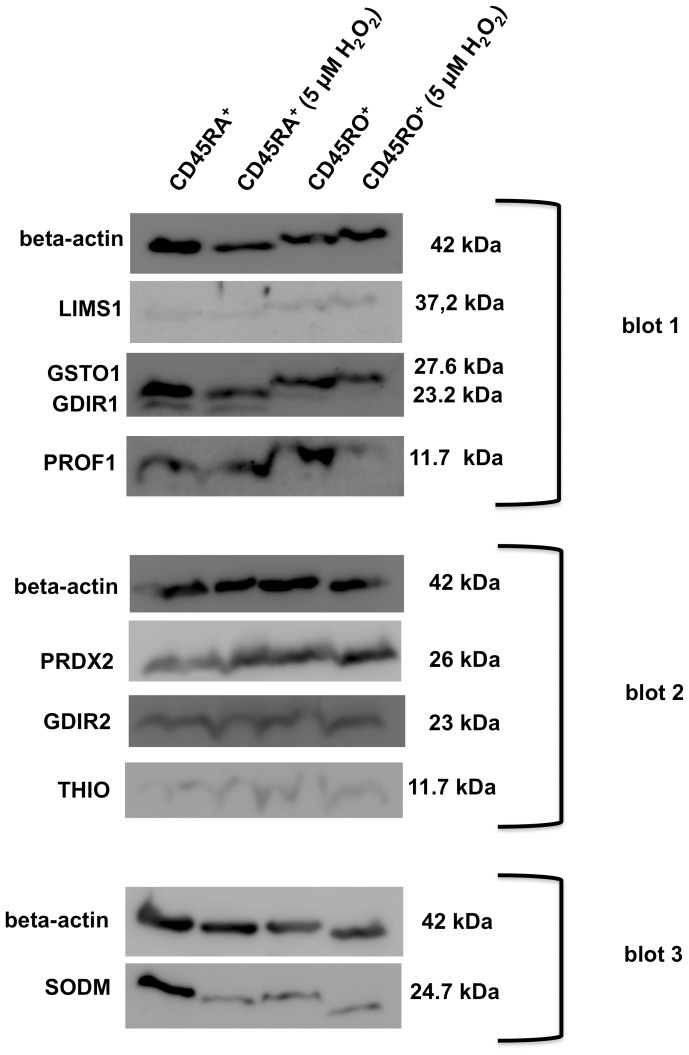
Representative Western blot analysis for the selected panel of differentially expressed targets in the various T cell subsets.Western blot analyses were performed by serially probing sets of 3 membranes per donor as outlined in the Material and methods section. The expression levels of GDIR1, GSTO1, LIMS1 and PROF1 were analyzed blot 1 (upper panel), GDIR2, PRDX2 and THIO on blot 2 (middle panel) and SODM on blot 3 (lower level) of the respective membrane set. The relative expression levels were defined by densitometric quantification normalized to the corresponding beta-actin signals, co-detected on each membrane. Aliquots of 15 µg total lysate per sample/lane were loaded onto Tris-Tricine gels (16%T/2.5%C) and subsequently separated and processed as outlined in the Materials and method section. Lysates generated form untreated CD45RA+ and CD45RO+ T cells were throughout the set of membranes loaded onto the lanes 1 and 3 respectively, whereas lysates generated from the corresponding T cell subsets exposure for 3 h to 5 µM H2O2 were loaded onto the lanes 2 and 4 as indicated. The protein entry names of the targets (left) and their corresponding molecular weight (right) are listed.